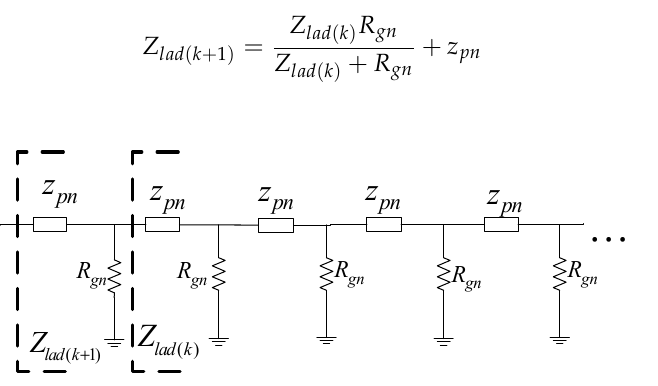
Figure 4. The equivalent circuit of multi-grounding neutral ladder network.